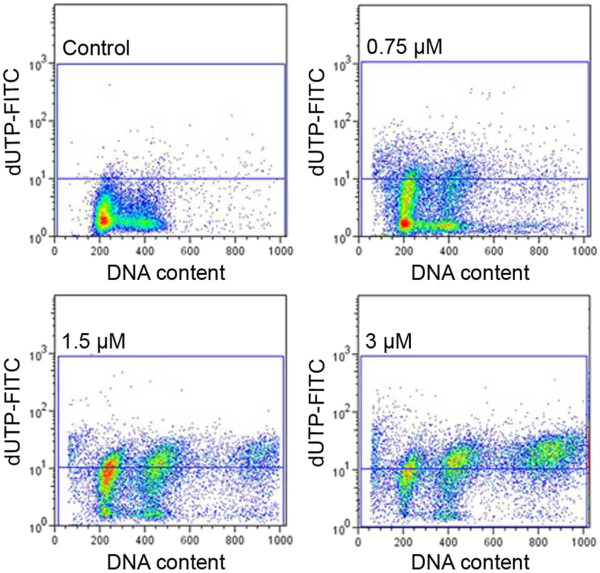
DNA fragmentation rate in relation to DNA content in A549 cells after treatment with etoposide - representative dot-plots from flow cytometric analyses (the TUNEL method); upper left - control cells, upper right - 0.75 μM etoposide, lower left - 1.5 μM etoposide, lower right - 3 μM etoposide.